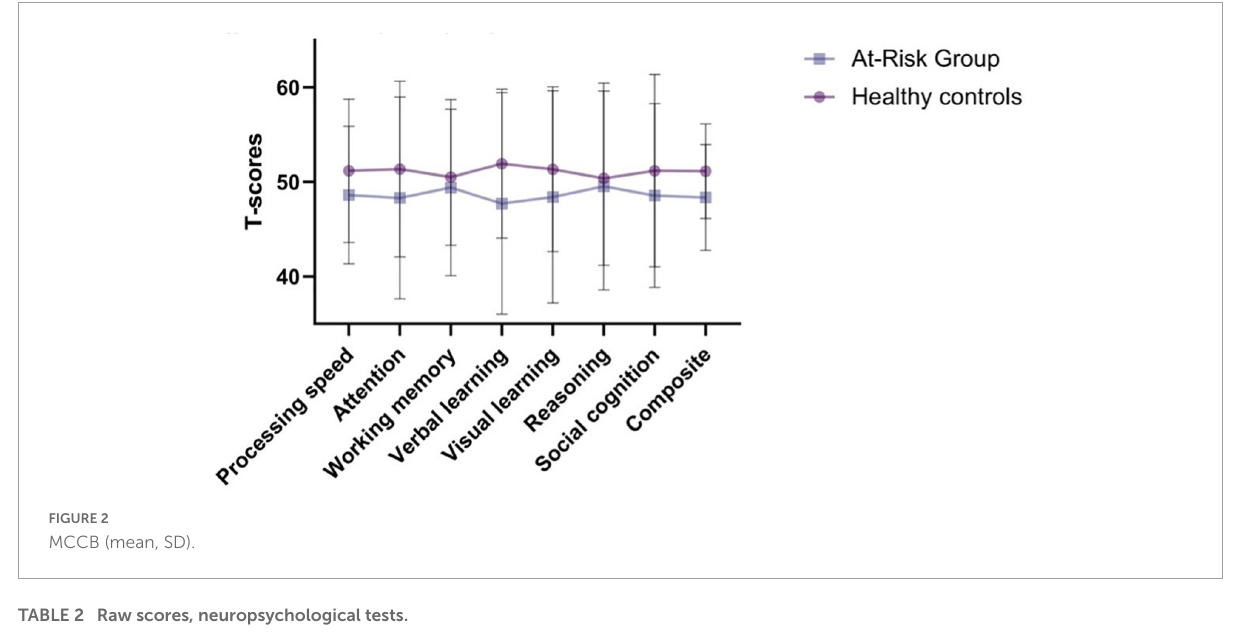
TABLE 2 Raw scores, neuropsychological tests. At-risk ( N = 46) Healthy controls ( N = 54) F p